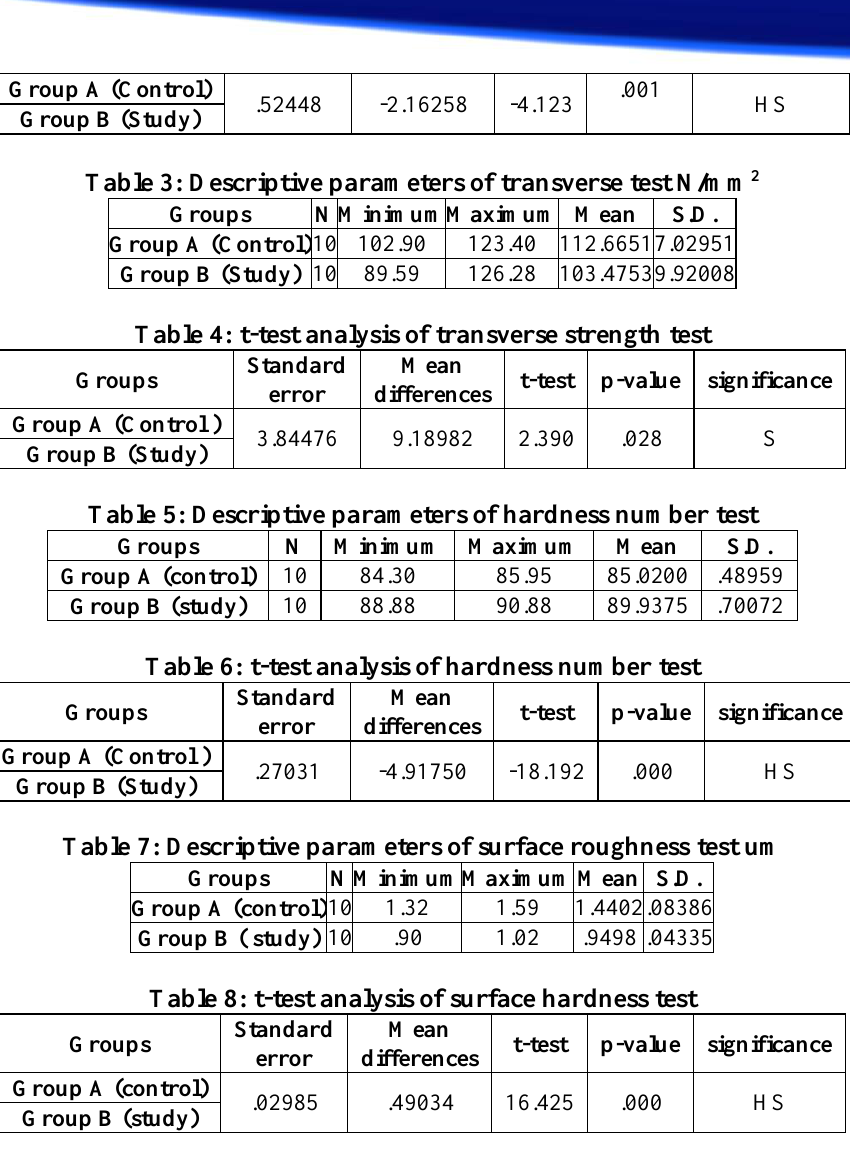
Table 9: Descriptive parameters of water sorption test mg/cm 2